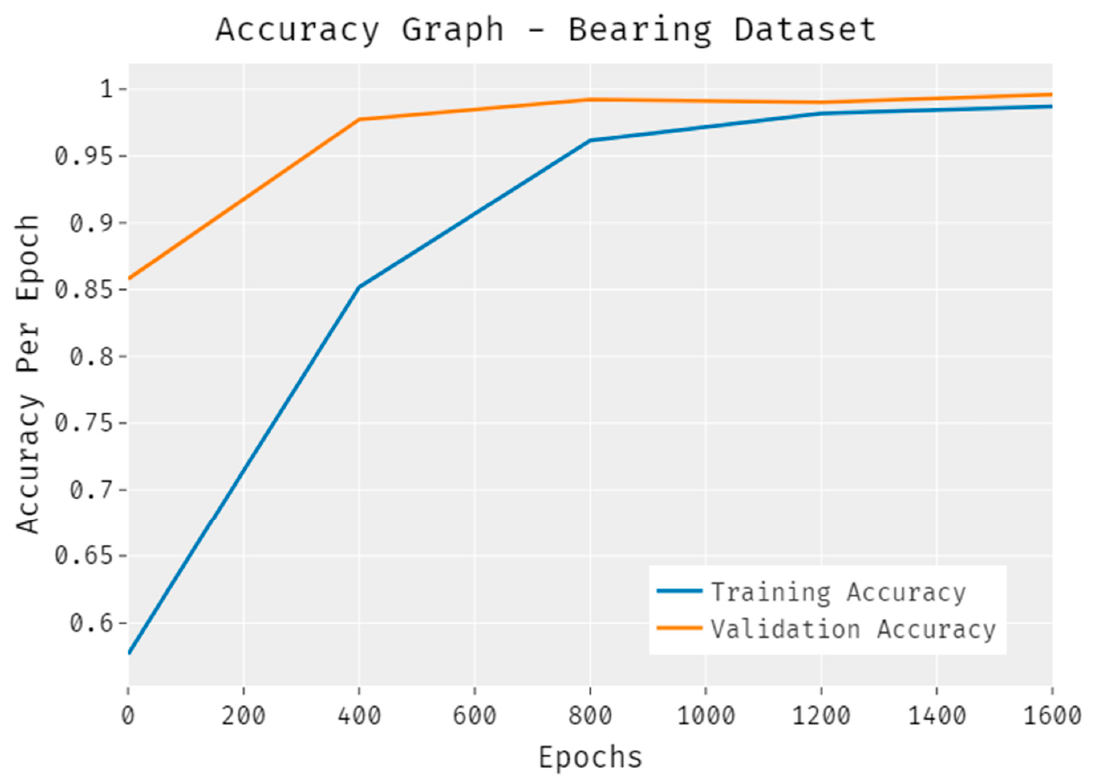
Figure 8. Accuracy analysis outcomes of SPOAI-FD technique under Bearing dataset.